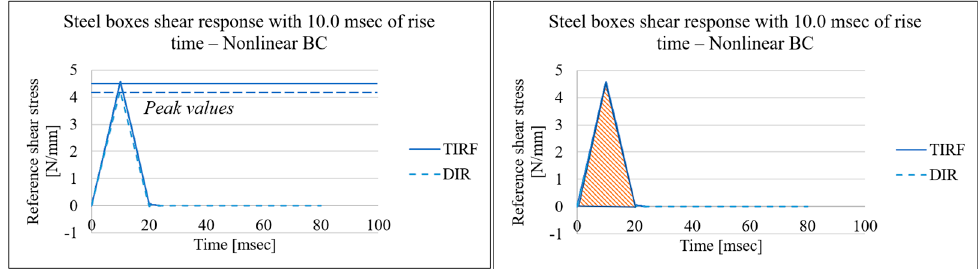
Figure 7. Peak values (ultimate structural response) and impulse values (shaded area).